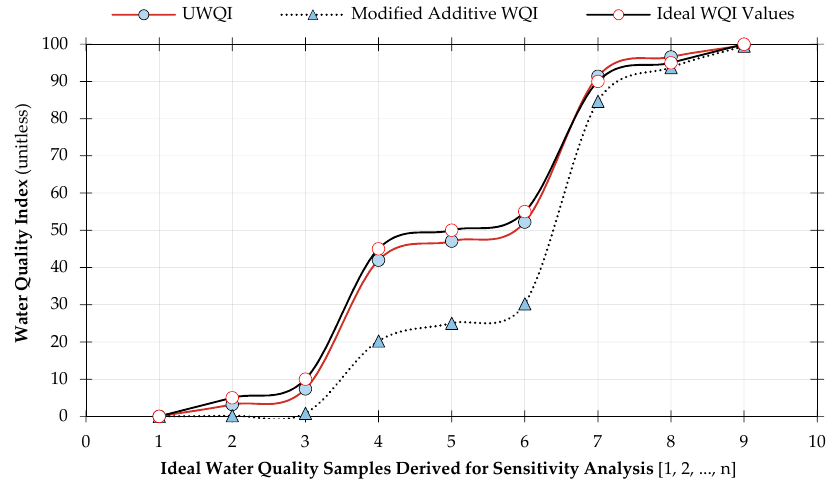
Figure 4. Plot diagram showing the results of the scenario-based analysis of the developed universal water quality index (UWQI) model and the modified additive water quality model against ideal water quality values derived from nine probable scenarios. The nine cases were represented as samples 1, 2, ... , n, which correspond, respectively, to water quality index (WQI) values of 0, 5 and 10 (worst-cases), 45, 50 and 55 (base cases) and 90, 95 and 100 (best cases).